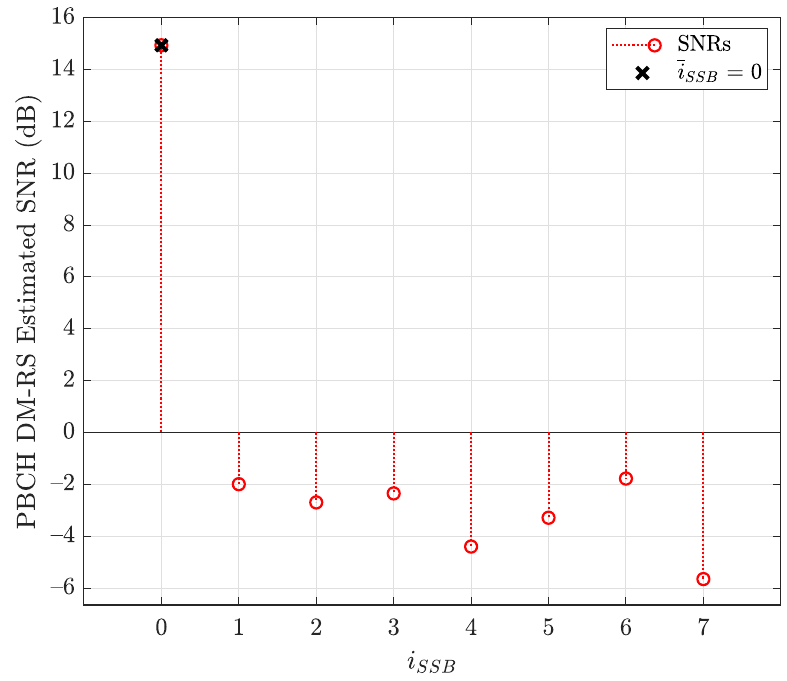
Figure 10. PBCH demodulation reference signal estimated SNR versus i SSB